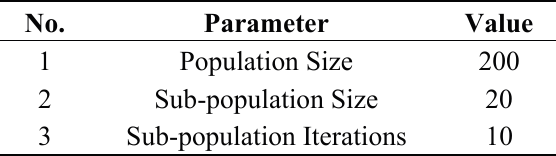
Table 4. The parameters of SFLA.